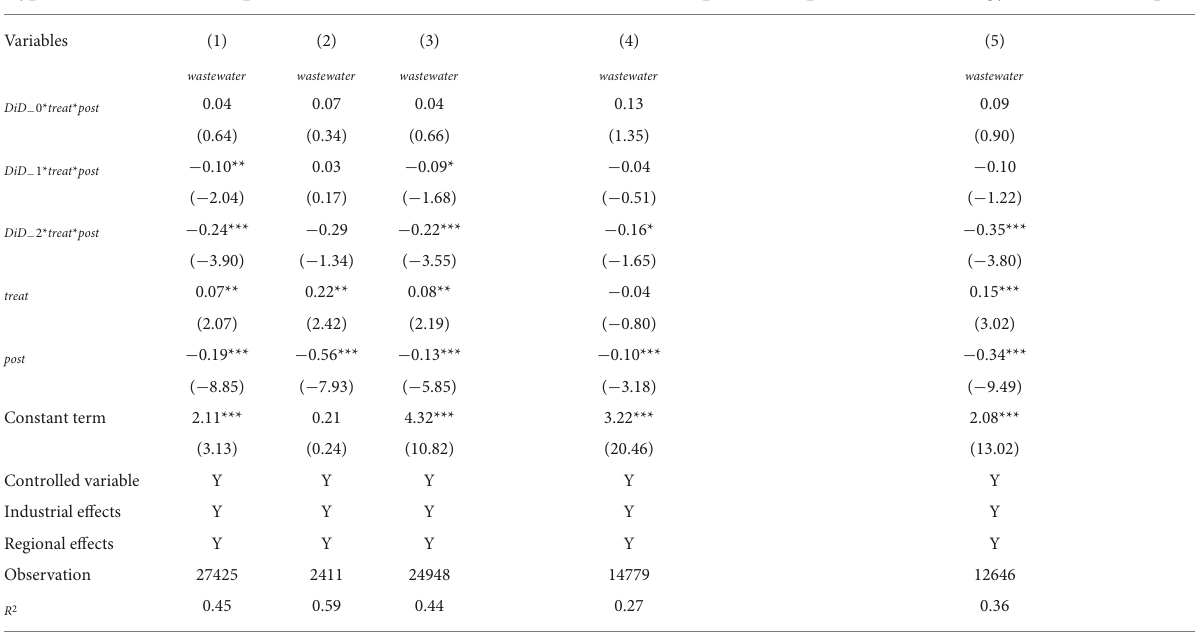
TABLE 5 Dynamic marginal effects of total industrial wastewater emissions.